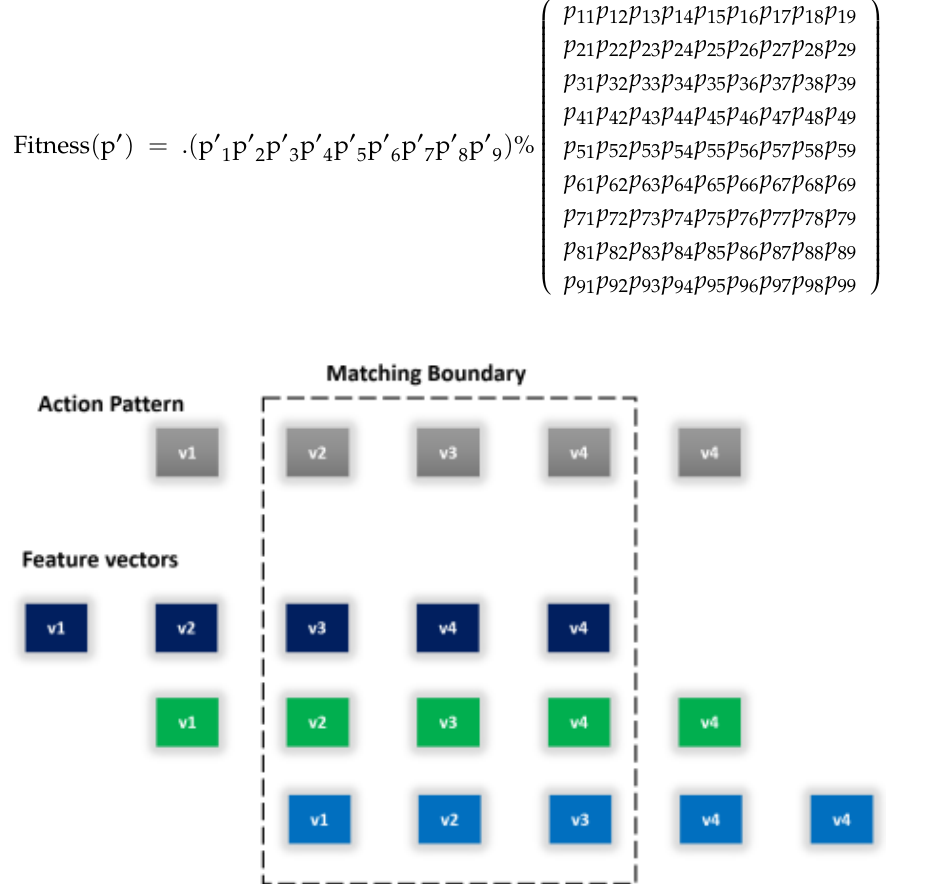
Figure 10. The reweighted pattern-matching algorithm for human physical healthcare pattern understanding.